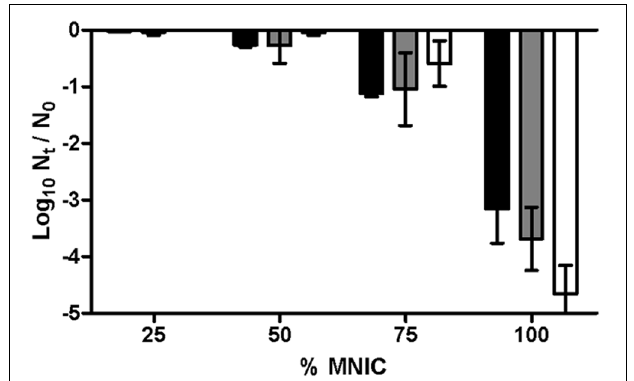
FIGURE 5 | Log 10 cycles of survival fractions of E. coli BW25113 in M9 broth after 5 min of thermal treatment at 55 ◦ C and after incubation in M9 agar added with NaCl (black bars), KCl (gray bars), or saccharose (white bars) at different proportions of their respective MNICs (3.00% NaCl, 3.88% KCl, or 58.53% saccharose). Error bars represent standard deviation of the mean from three replicates.